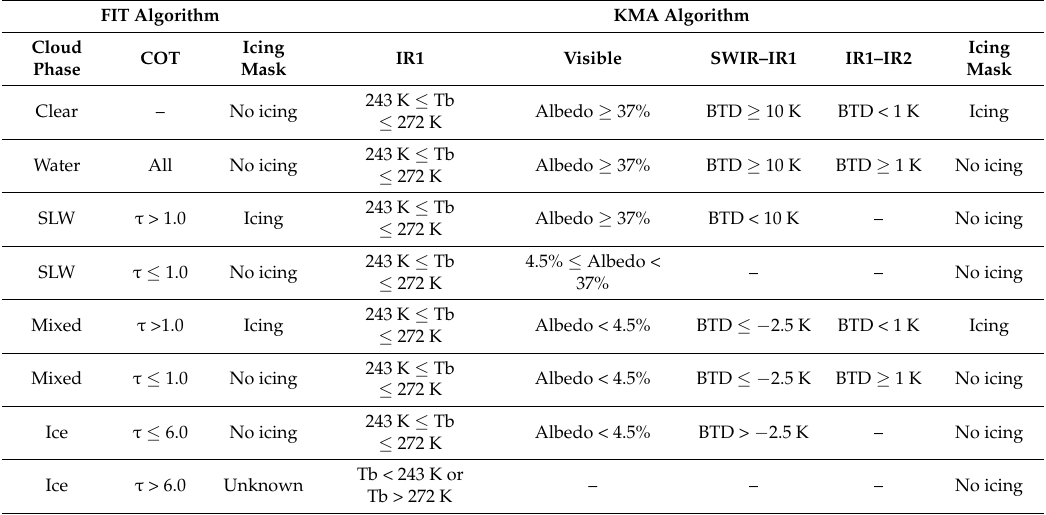
Table 4. Existing rule-based icing detection approaches (i.e., flight icing threat (FIT) and Korea meteorological administration (KMA) algorithms to produce icing